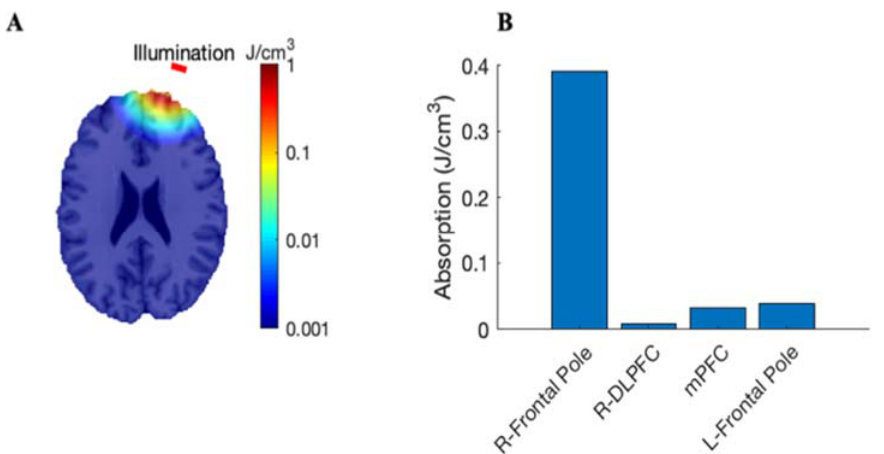
Figure 1. ( A ) Simulated light absorption in a template head (“Colin27”) when targeting the right frontal pole. Light propagation through the heterogeneous head volume was simulated using the Monte Carlo Multi ‐ Layer (MCML) technique after assigning the appropriate optical properties to the head model and computing the energy absorbed at each location [18]. The displayed axial slice matches the site of illumination (red bar). The absorption spans three orders of magnitude and decays rapidly in both depth and lateral directions. ( B ) The absorption at the targeted structure (R ‐ Frontal Pole) approaches 0.4 J/cm 3 , while being limited to less than 0.05 J/cm 3 in non ‐ targeted regions such as the right dorsolateral prefrontal cortex (R ‐ DLPFC), medial prefrontal cortex (mPFC), and left frontal pole (L ‐ Frontal Pole).